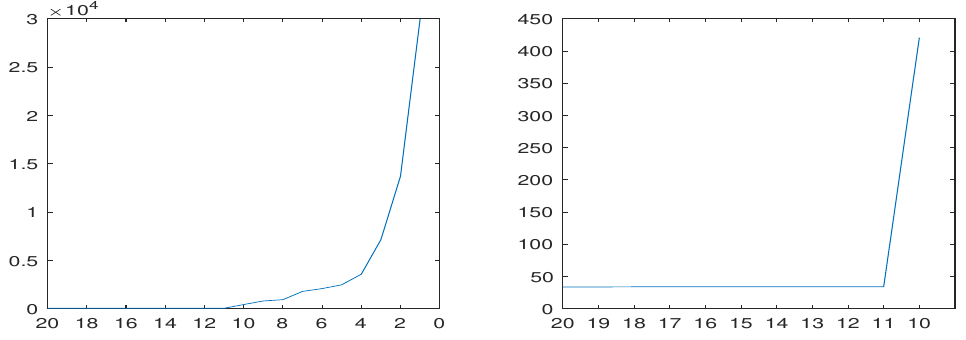
Figure 9: Left side: | λ 20 ( A n ) | < ··· < | λ 1 ( A n ) | ; right side: | λ 20 ( A n ) | < ··· < | λ 10 ( A n ) | in a typical realization in case (a) of Example 5.7.